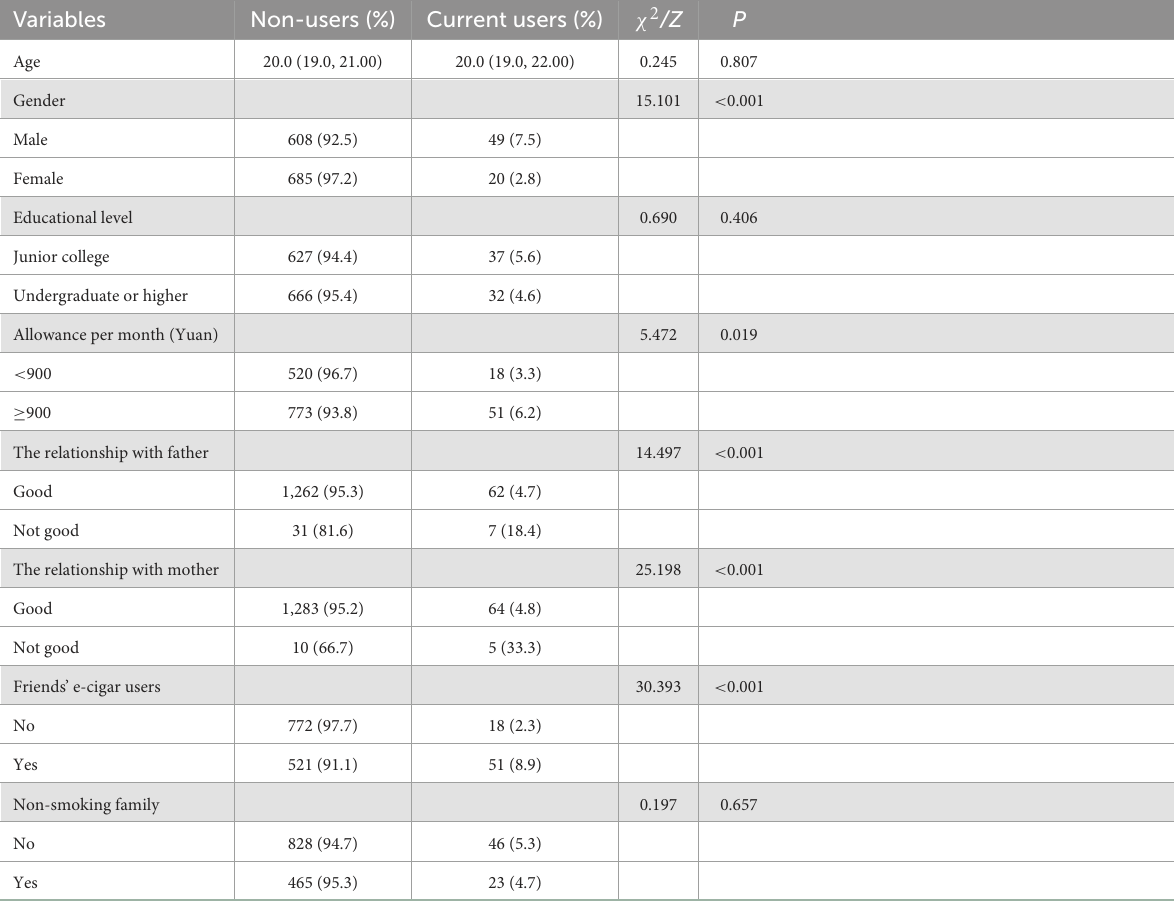
TABLE 2 Comparing the demographic characteristics between non-users and current users.